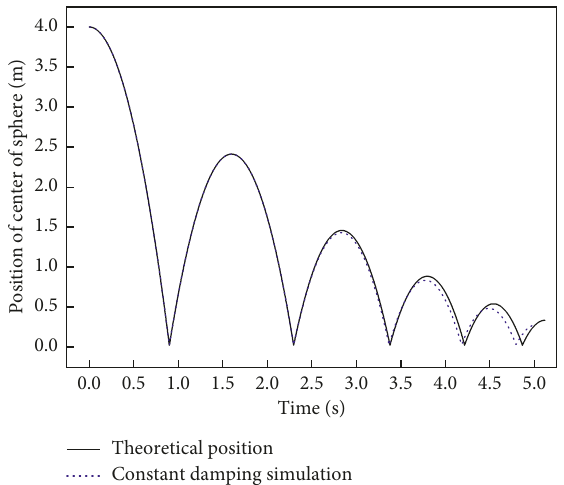
Figure 4: Position of the center of the rock